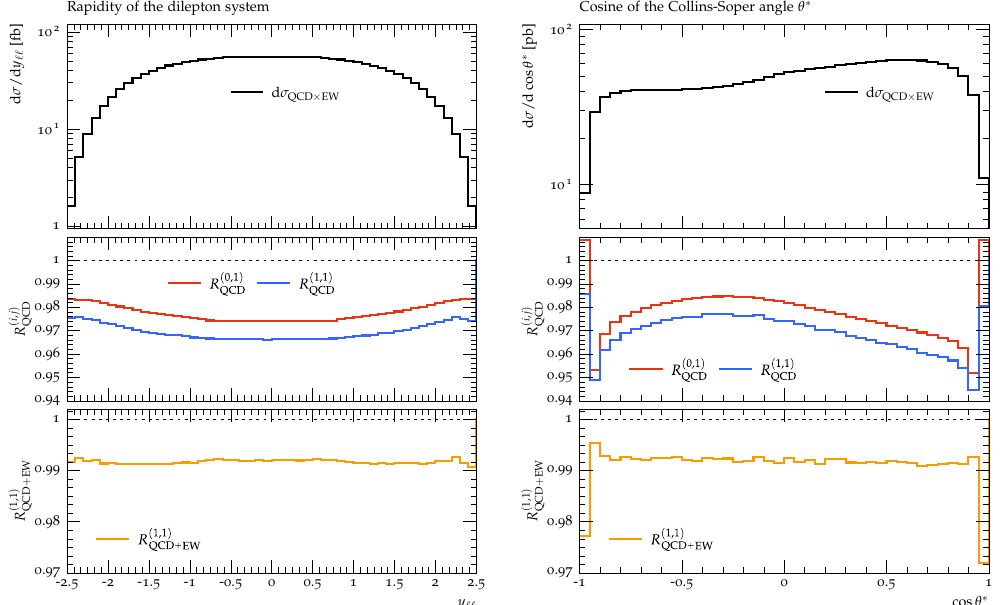
Figure 4 . Distributions of the rapidity of the dilepton system and the cosine of the Collins-Soper angle. See the caption in figure 2 and the text for